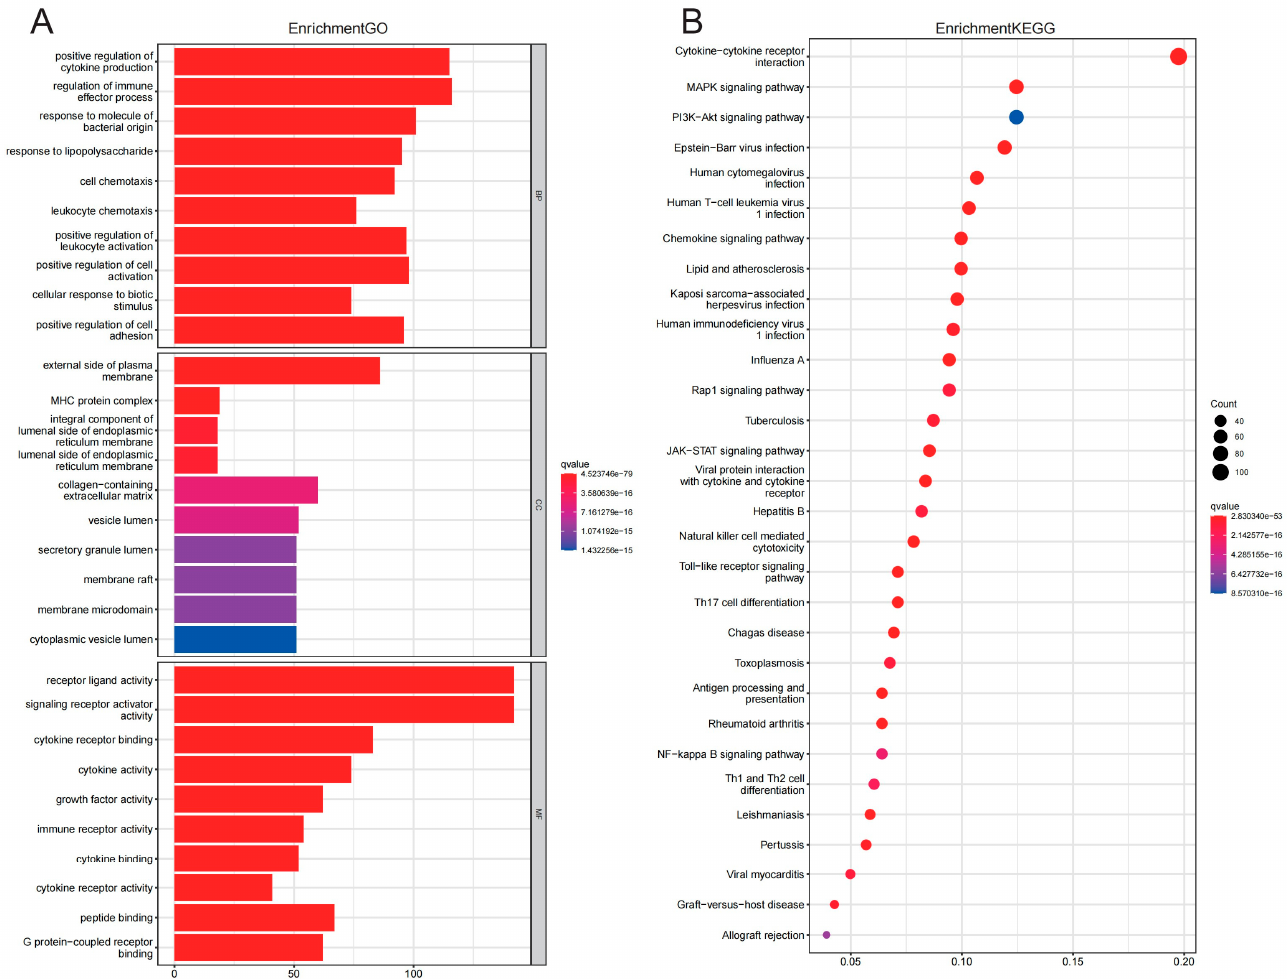
Figure A1. ( A,B ) The annotation results of GO and KEGG enrichment analysis on the immune-related DEGs.